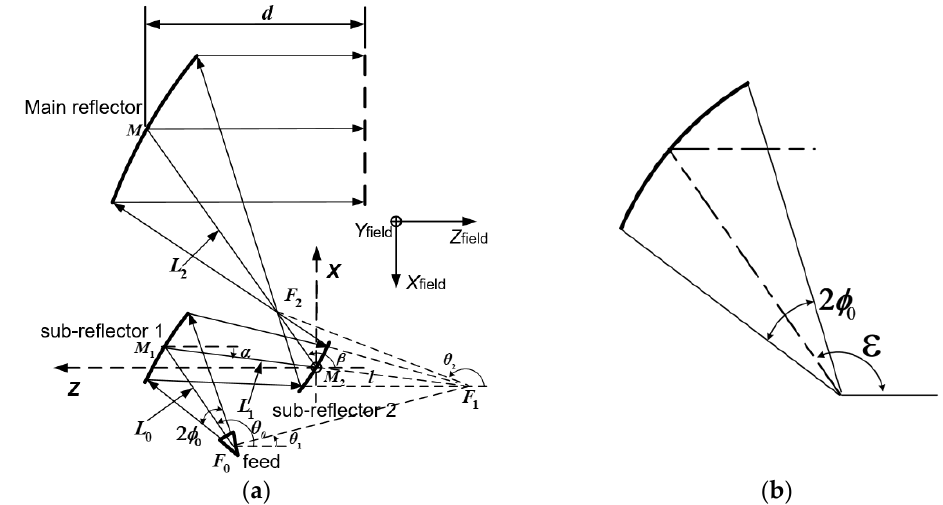
Figure 1. ( a ) Schematic diagram and design parameters of a tri-reflector system; ( b ) the equivalent paraboloid of a tri-reflector system.